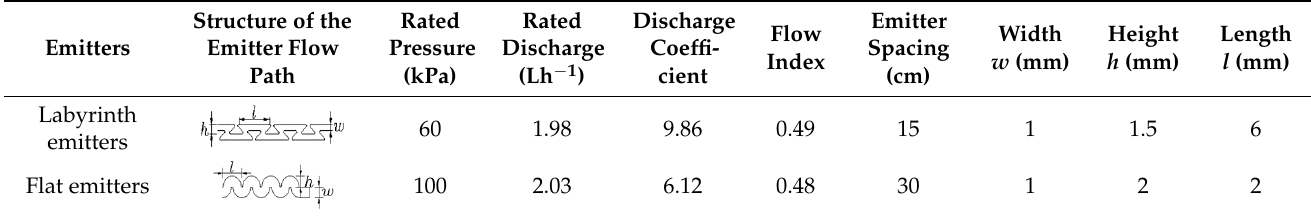
Table 2. Structural parameters of emitters.